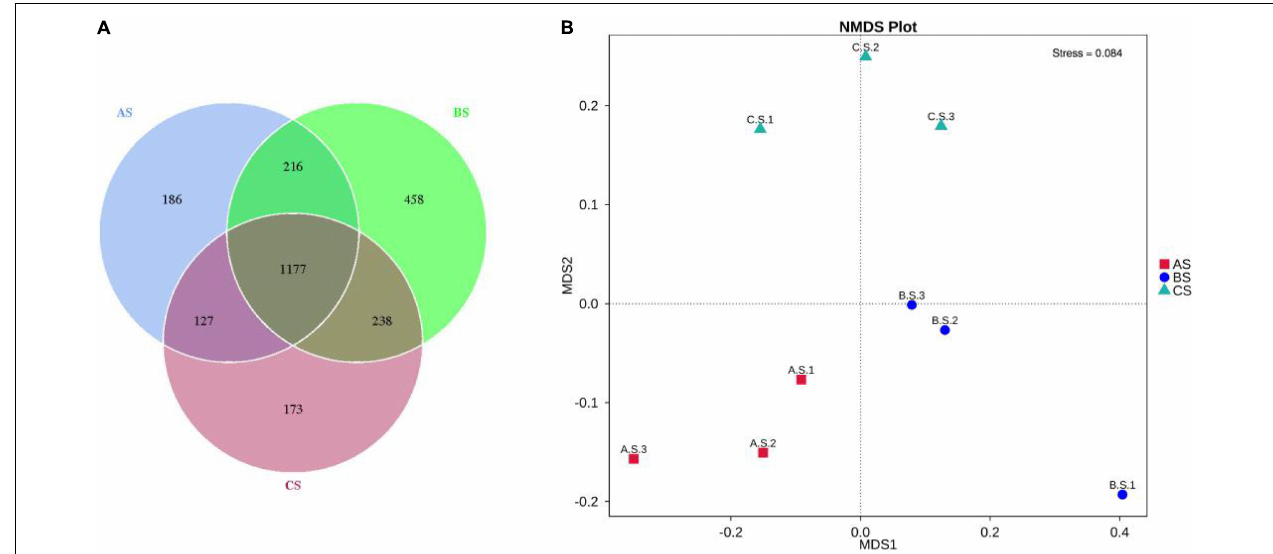
FIGURE 3 | Venn diagram of microbial communities at OTUs level among AS, BS, and CS (A) , NMDS analysis (B) among microbial communities ( n = 9). AS, water sample; BS, biofloc sample; CS, intestinal sample, OTUs, operational taxanomic